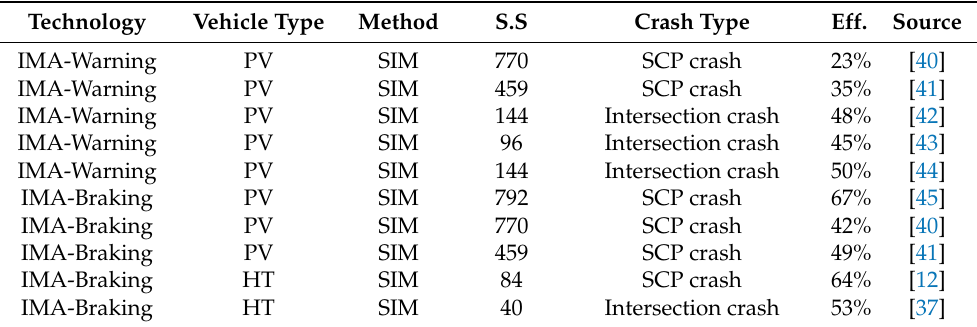
Table 5. Evidence for the crash avoidance effectiveness of